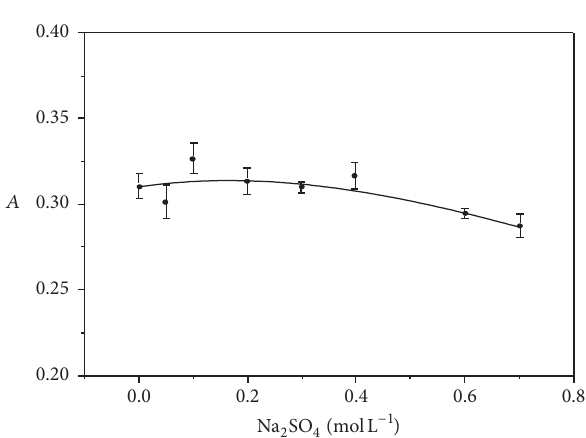
Figure 6: Concentration effect of Na 2 SO 4 (0–0.7 mol L −1 ) on the AOF-KMnO 4 system, with AOF 2.3 × 10 −5 molL −1 , NaOH 0.30 mol L −1 , KMnO 4 9.0 × 10 −4 molL −1 , t = 30 min, T ∘ = 50 ∘ C, and monitoring at 610nm.